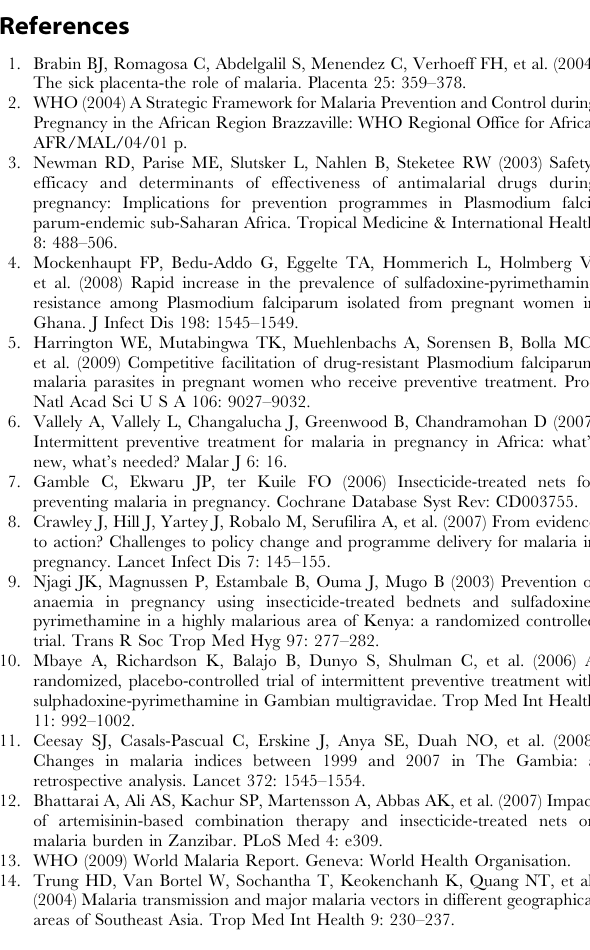
Table S1 Comparison of SP-IPTp with IST in women who were RDT negative throughout pregnancy and did not receive an antimalarial.